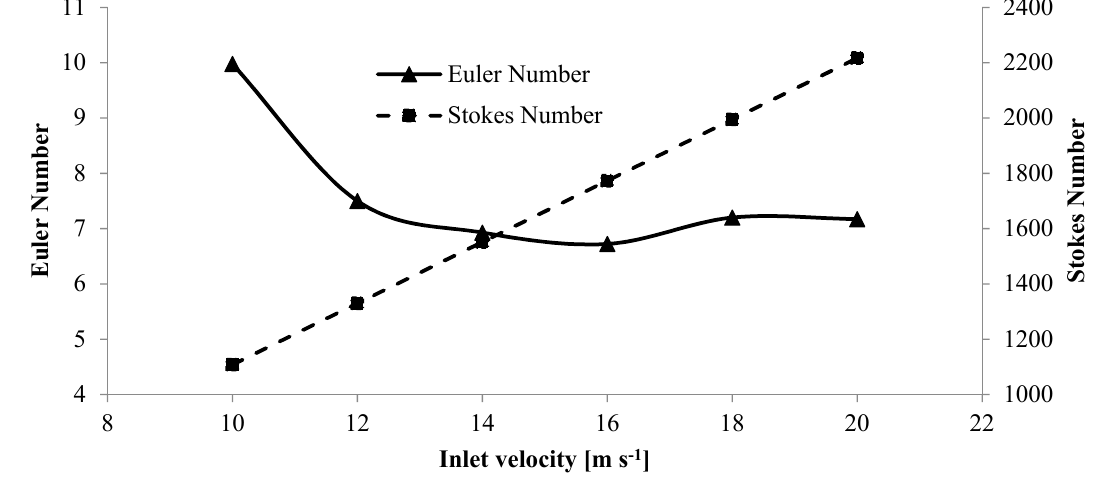
Figure 10. Euler and Stokes numbers variation in various inlet velocities.